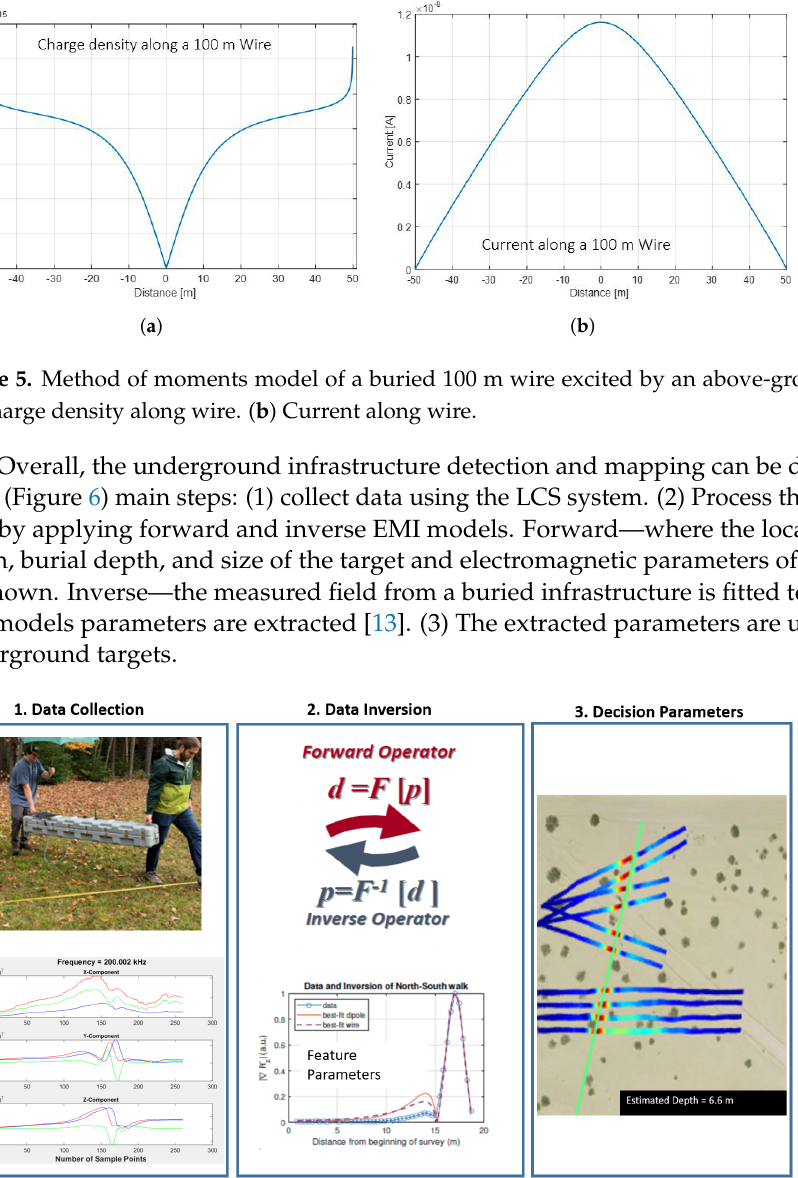
Figure 6. Graphical representation of solving an inversion EM